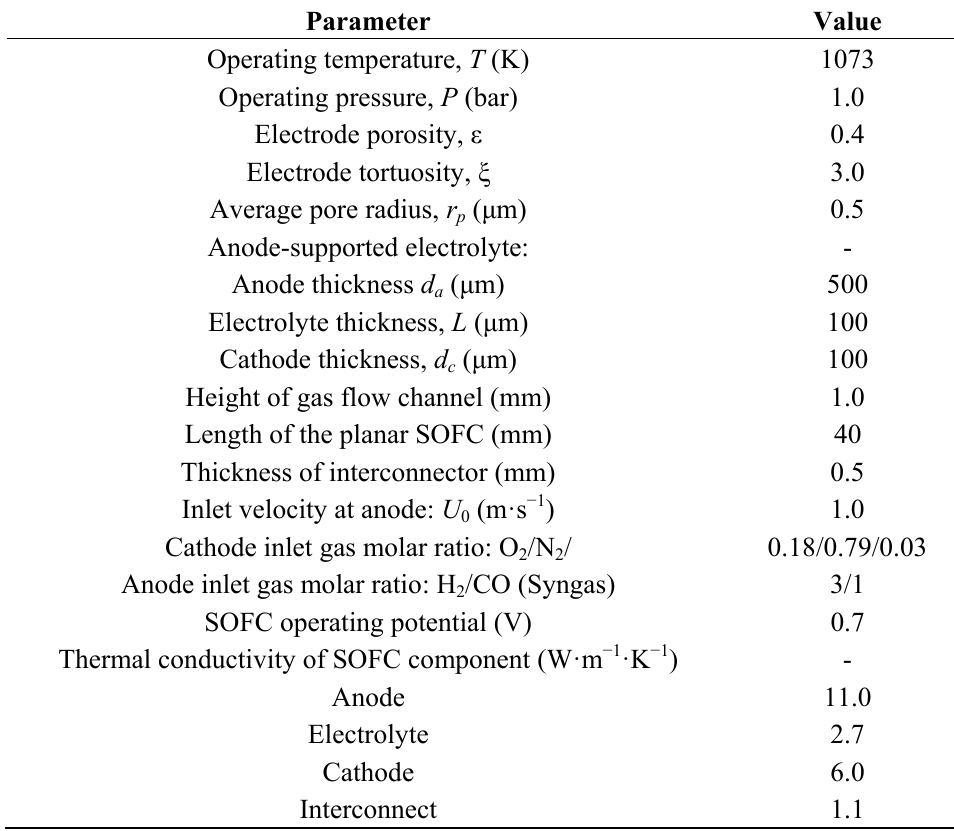
Table 2. Parameters used in